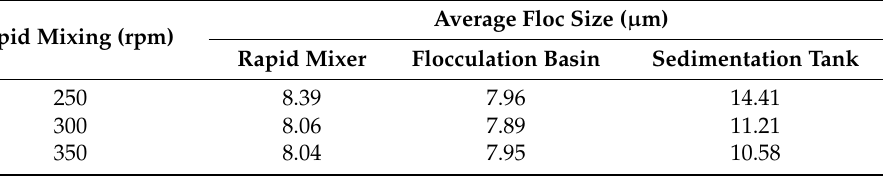
Table 3. Average floc size in different process units.